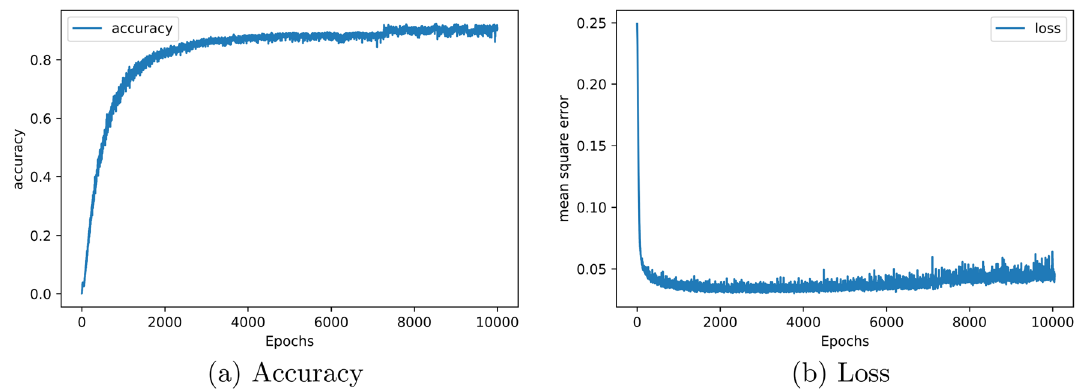
Figure 5. Curves of ( a ) accuracy and, ( b ) loss function relative to 10,000 Epochs for restricted network